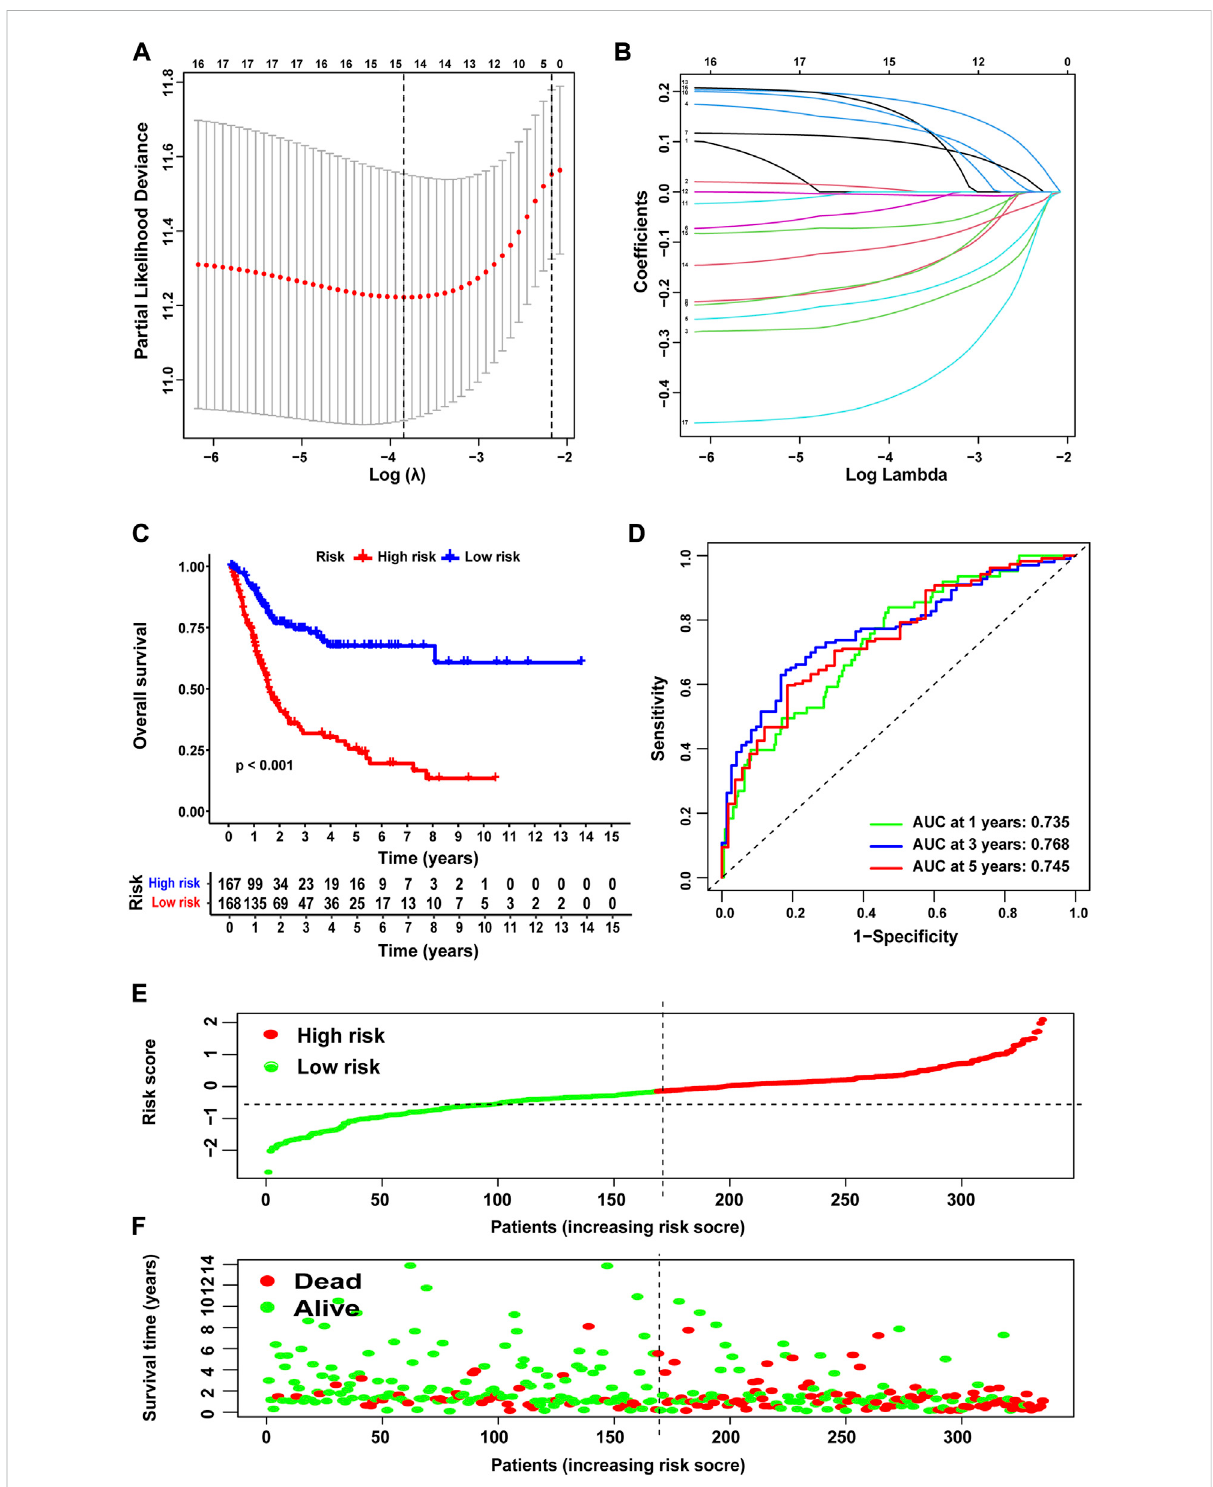
FIGURE 4 Construction of NRG score and prognosis analysis based on TCGA cohort. (A,B) LASSO Cox regression analysis. (C) Kaplan – Meier survival analysis between NRG score-de fi ned groups. (D) Time-dependent ROC curves and AUCs at 1-, 3-, and 5-year survival for the 0 NRG score. (E) NRG score distribution. (F) Survival status